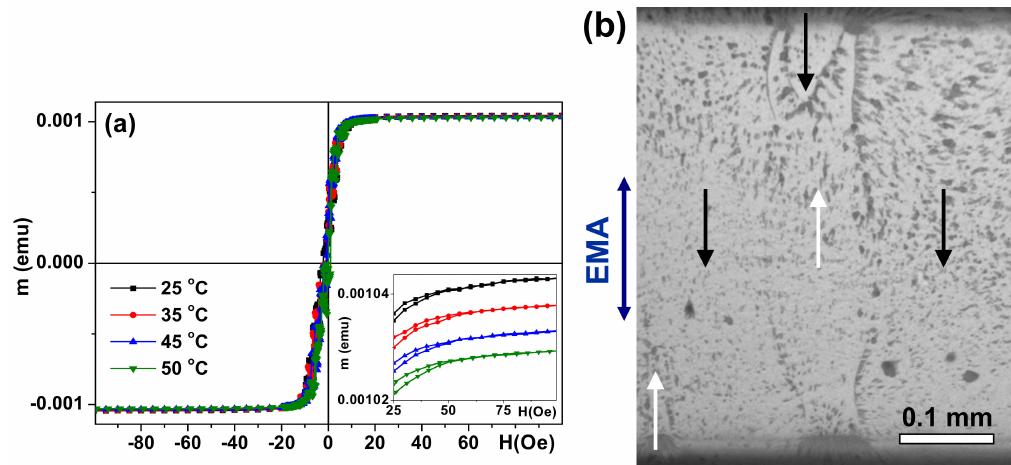
Figure 3. S-type multilayered structure. SQUID hysteresis loops measured along the hard magnetization axis in the plane of the film for selected temperatures: the inset shows field dependencies of magnetic moments (m) for selected temperatures at better resolution ( a ). The surface magnetic domain structure revealed by Akulov-Bitter technique with ferrofluid at room temperature (25 ◦ C) in the S sample: black and white arrows indicate the orientation of the magnetization in the domains, and the easy magnetization axis (EMA) is oriented in the same direction as the direction of the applied field during thin film deposition, being parallel to the short side of the elongated stripe ( b